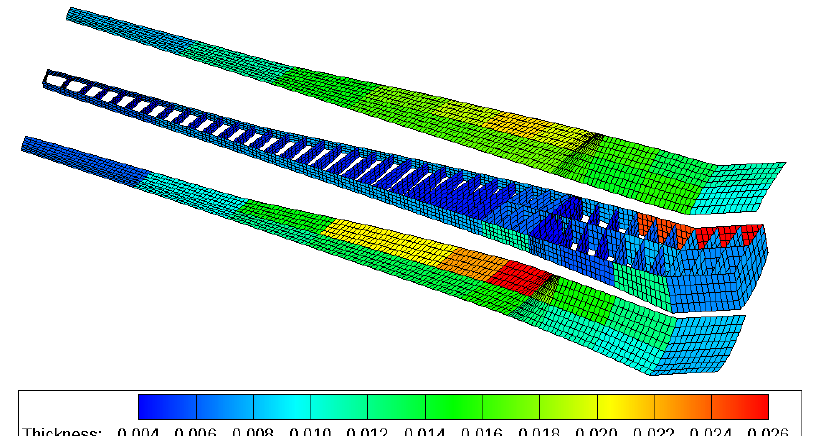
Figure 24. Material thickness distribution in m—passive variant.